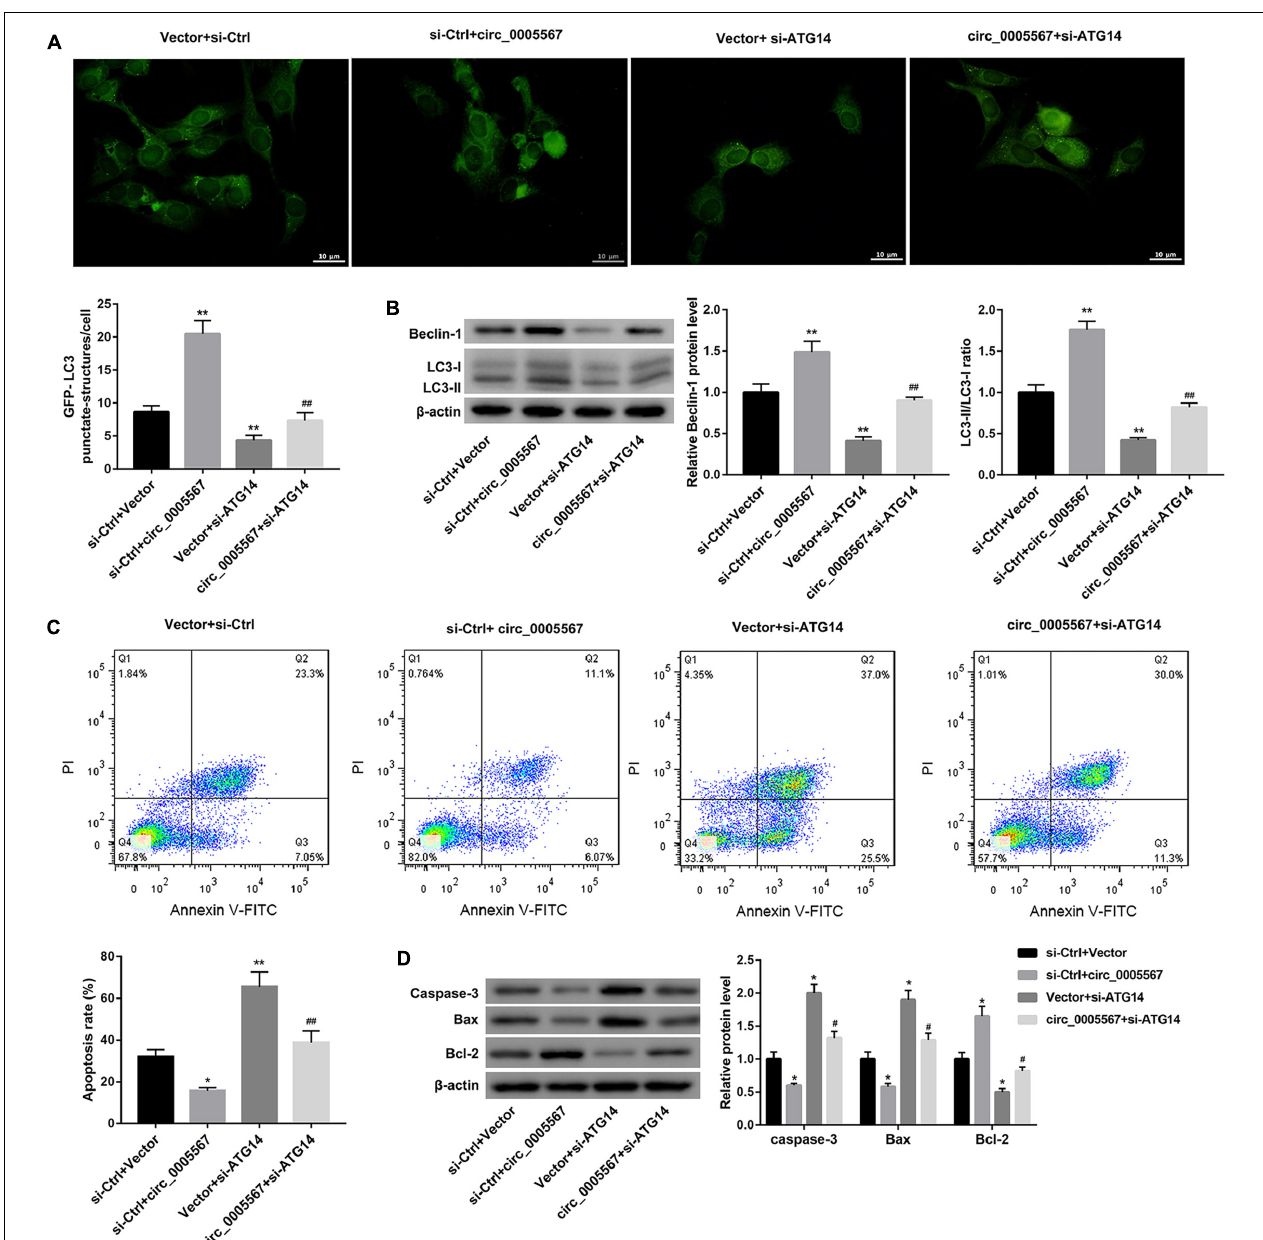
FIGURE 6 | Circ_0005567 promoted autophagy and inhibited chondrocyte apoptosis by upregulating ATG14 expression. (A) Immunofluorescence results of chondrocytes transfected with GFP-LC3, (B) protein levels of Beclin-1 and LC3-II/LC3-I examined by western blot, (C) cell apoptosis rate determined by flow cytometry after Annexin V-FITC/PI staining, and (D) protein levels of caspase-3, Bax, and Bcl-2 examined by western blot in chondrocytes co-transfected with si-ATG14/si-Ctrl and circ_0005567 overexpression vector/empty vector in the presence of IL-1 β . The data are expressed as mean ± standard deviation from three independent experiments. * P < 0.05, ** P < 0.01, versus the si-Ctrl + Vector group; # P < 0.05, ## P < 0.01, versus the si-Ctrl + circ_0005567 or Vector + si-ATG14